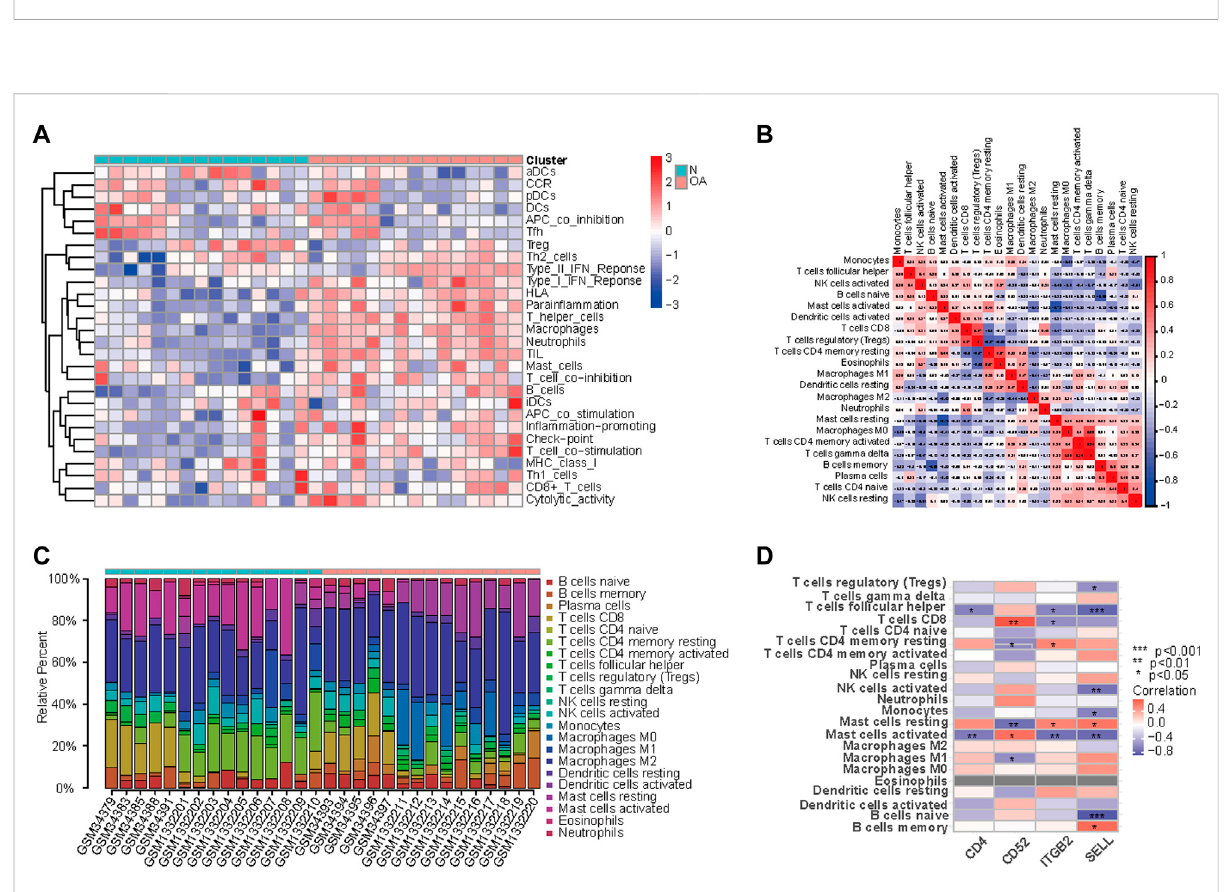
FIGURE 6 Landscape and correlation heatmap of 29 immune-related gene sets. (A) Relative distribution of 22 kinds of immune cells in all samples. (B) Correlation heatmap of immune cells in all samples. Red squares indicate positive correlation, and blue squares indicate negative correlation; the deeper color squares indicate stronger correlations. (C) Bar chart shows the composition of 22 immune cell types in the two groups. Each color represents a kind of immune cell. (D) Correlation between hub gene expression and immune cell in fi ltration. Red squares indicate positive correlation, and blue squares indicate negative correlation; the deeper color squares indicate stronger